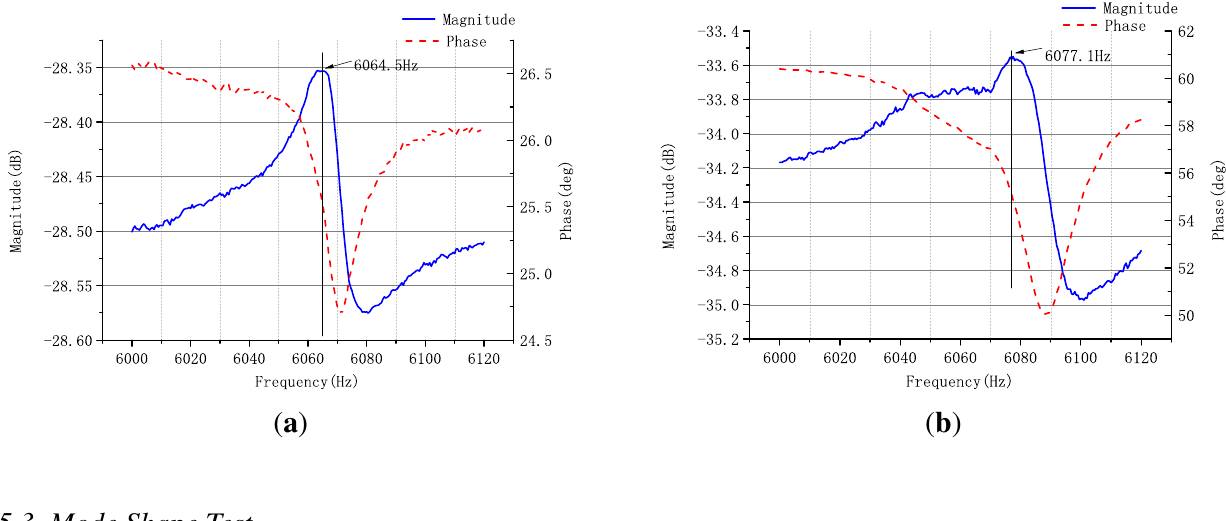
Figure 12. Resonating response of active mode: ( a ) active mode; ( b ) sense mode.